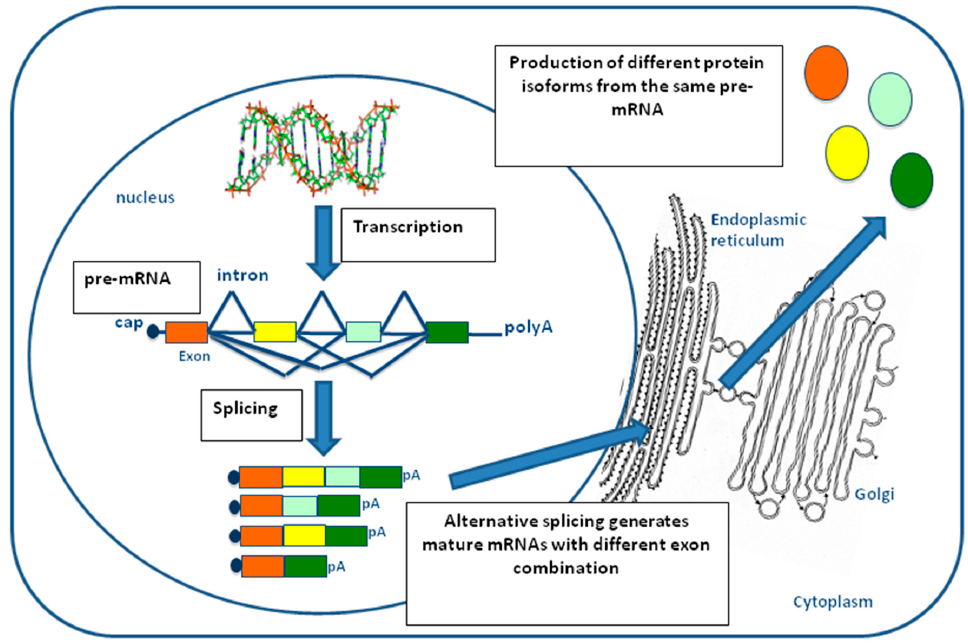
Figure 2. Schematic representation of the splicing process. In pre-mRNA molecules, exons are represented by colored squares and introns by lines. During the alternative splicing process, some exons within a pre-mRNA molecule can be variably included/excluded from the splicing ‘queue’, giving rise to different protein isoforms (colored circles) that can possess distinct biological functions.